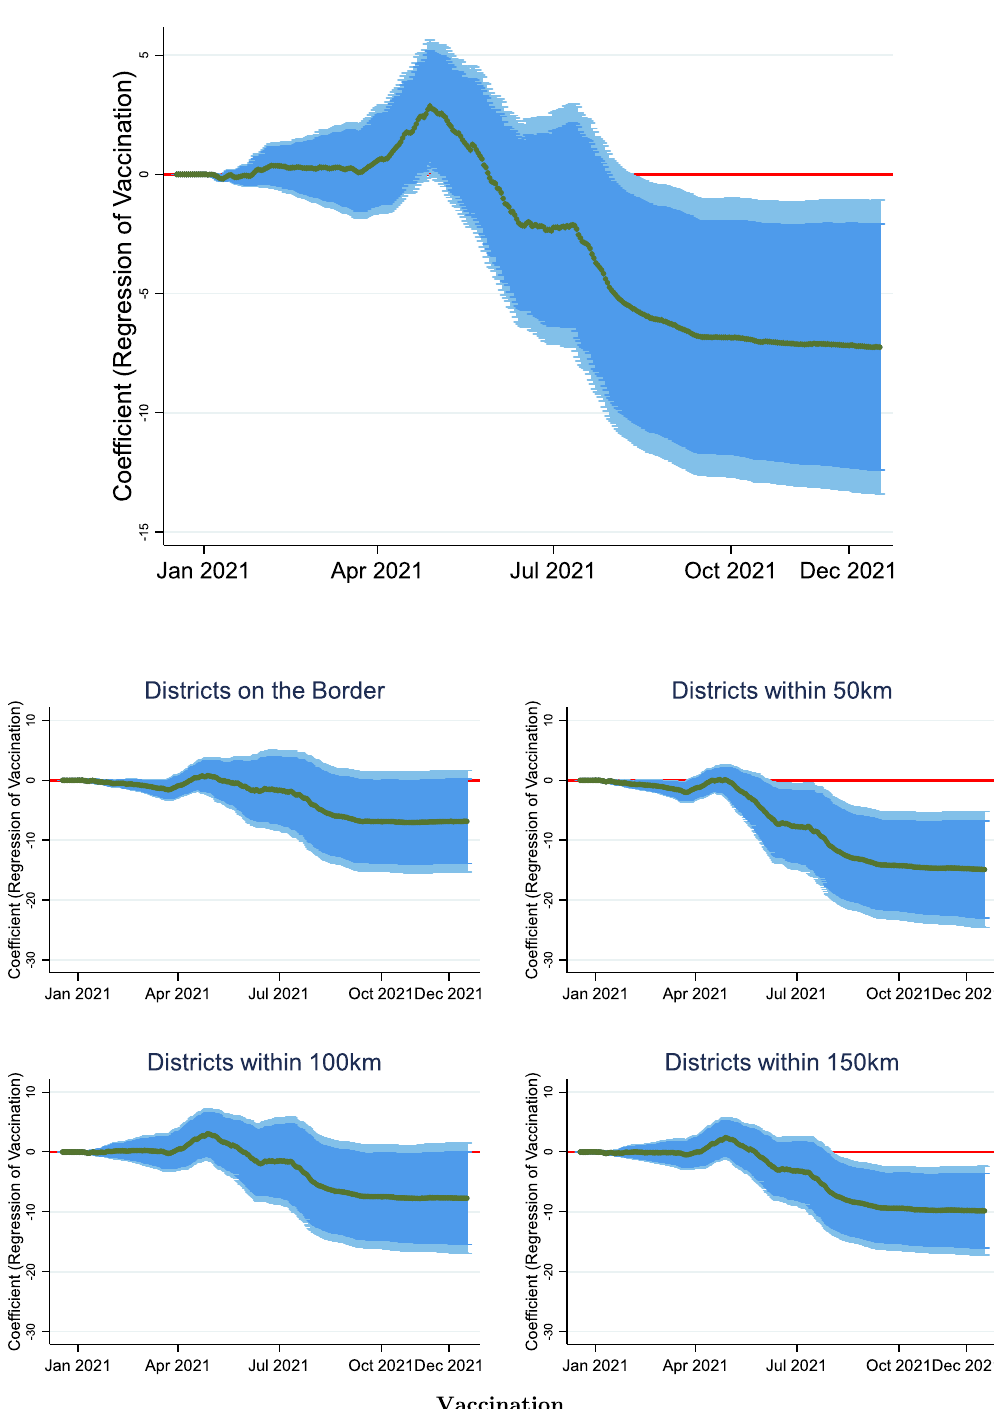
Fig. 6 Regression coef fi cients of vaccination on East for German districts. Daily regression coef fi cients (95 and 90% con fi dence interval) of vaccination on East for all German districts (Berlin excluded) and districts on the border or within 50/100/150 km of the border,